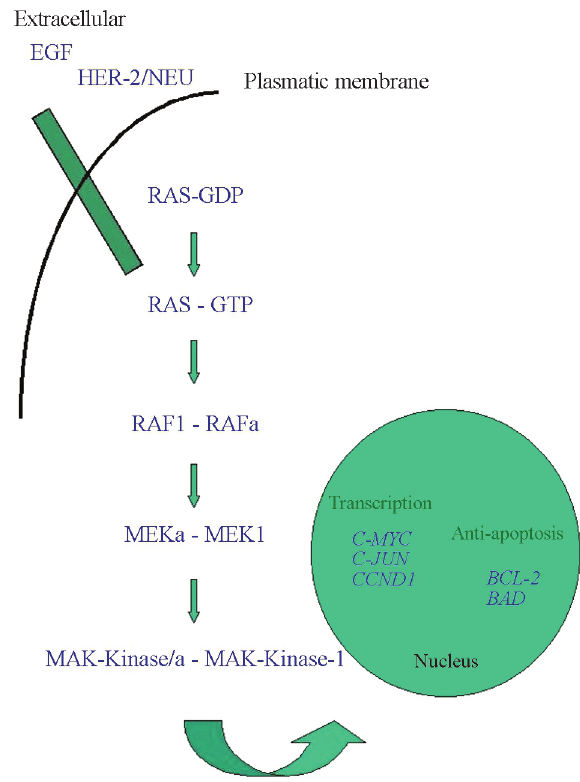
Figure 2 - Activation of epidermal growth factor receptor (EGFR) results in the initiation of a diverse array of cellular pathways. Dimerization re- sults in autophosphorylation, initiating a downstream cascade of events and culminating in cellular responses such as cell proliferation or apop- tosis. These protein interactions allowing Ras activation which this acti- vates the RAF-MEK-MAP-kinase signaling pathways which, in turn, activatetranscriptionfactors,suchasc-fos,c-mycandcyclinDwhichpro- mote gene expression and contribute to cell proliferation.